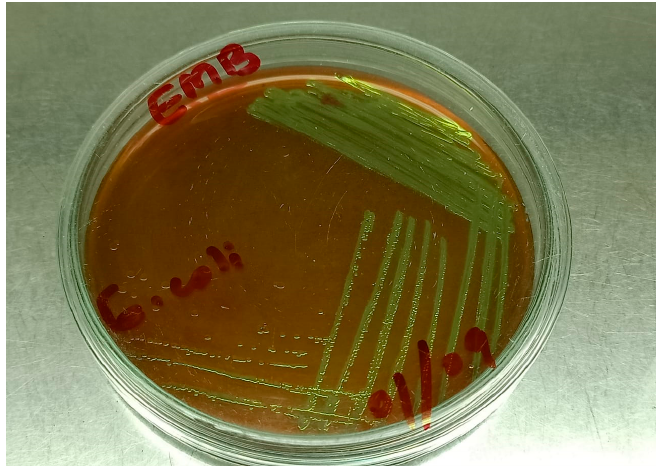
Appl. Sci. 2022 , 12 , x FOR PEER REVIEW